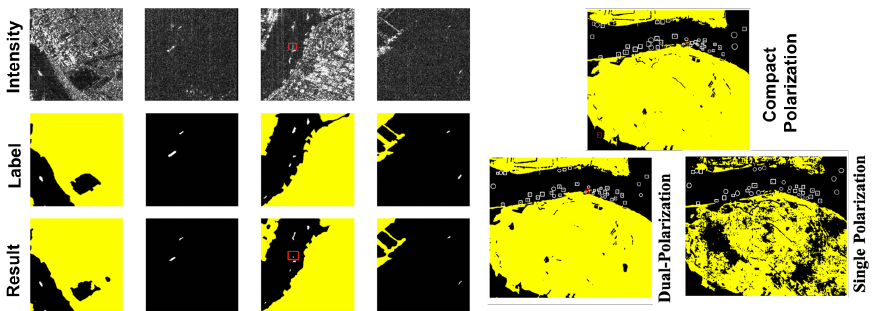
Figure 22. ( Up ) Illustrations of CPSAR images, corresponding label images, and detection results. ( Down ) Illustration of results from different polarization modes [91].